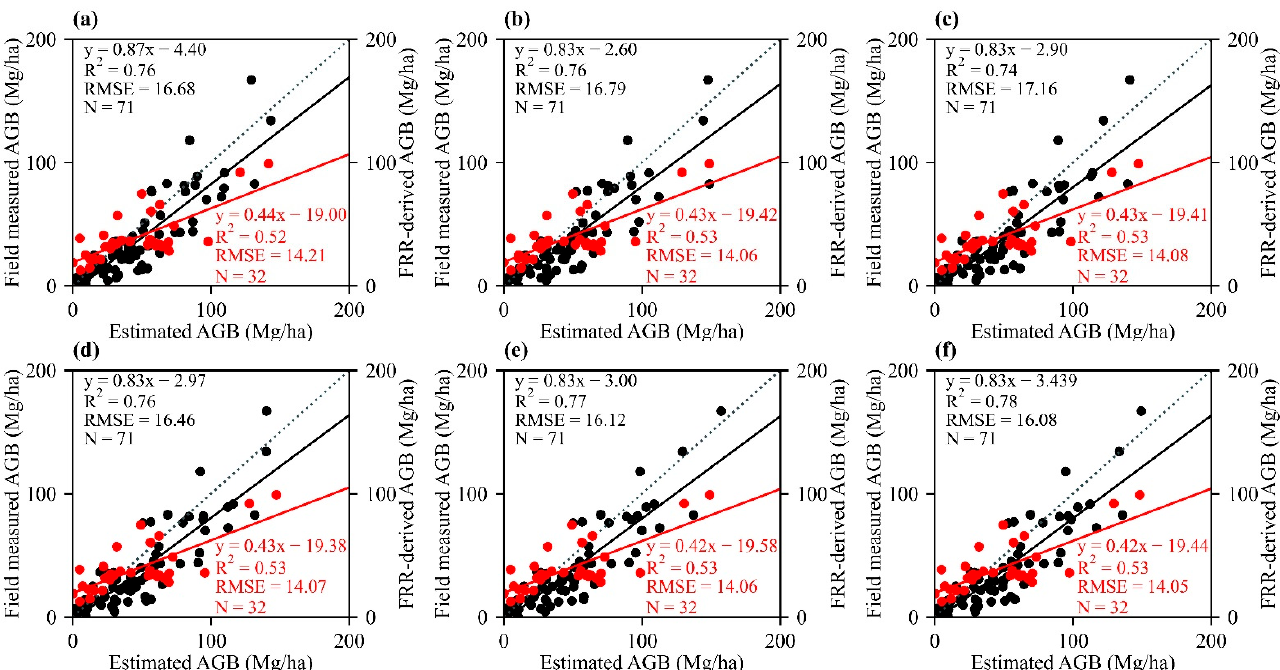
Figure 4. Validation results of the six models at the pixel and provincial level. The dotted lines are 1:1 line. The black contents are the verifications at the pixel level, and the red contents are the verifications at the provincial level. ( a ) RF, ( b ) GB, ( c ) XGB, ( d ) LGBM, ( e ) CatBoost, and ( f ) Stacked.